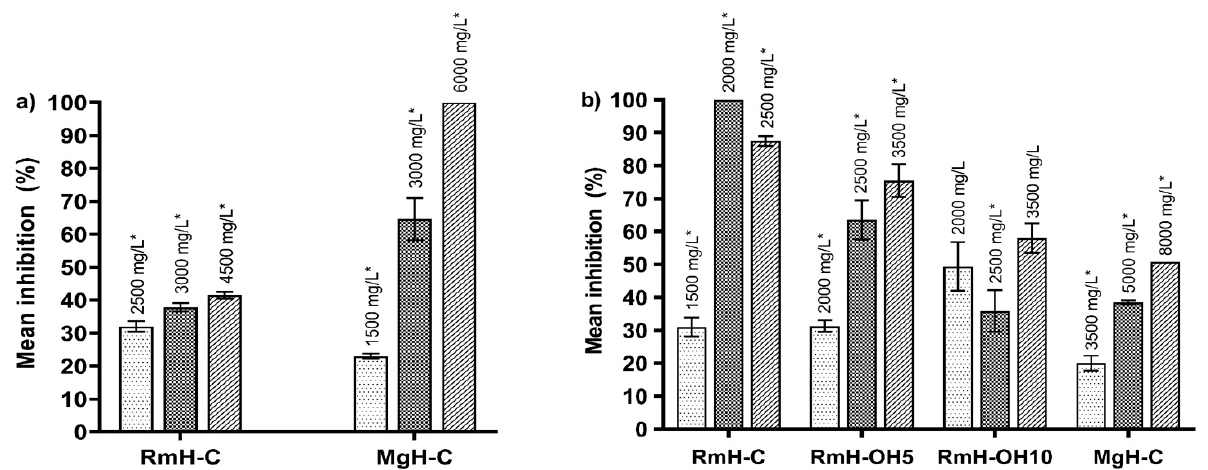
Figure 1. Mean inhibition (%) of R. microphylla (Rm) and M. geometrizans (Mg) fruit extracts against F. oxysporum ( a ) and R. stolonifer ( b ). Values are expressed as mean ± standard deviation (error bars), n = 4. The asterisk indicates significant difference between concentrations in each extract ( p < 0.05). H: hydroalcohol extract; C: conventional agitation; OH: ohmic heating; 5 and 10: correspond to operating time (min) for OH extraction.